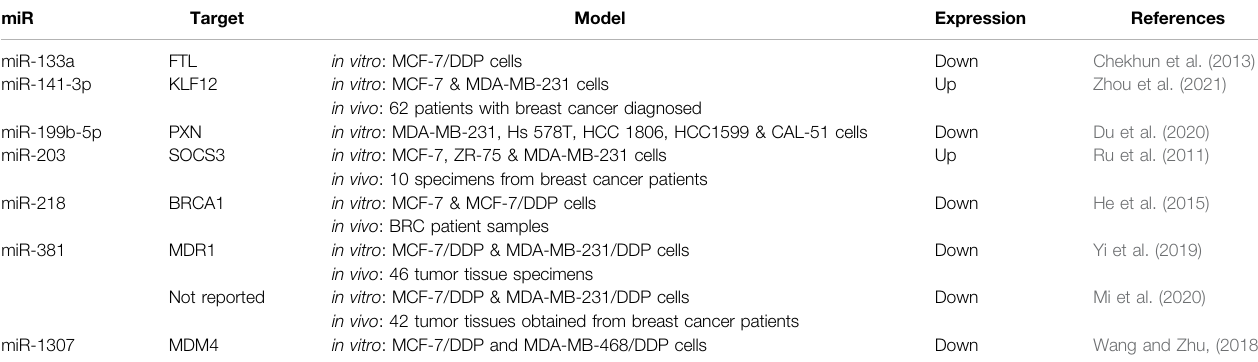
TABLE 4 | MicroRNAs involved in DDP-chemoresistance of breast cancer.